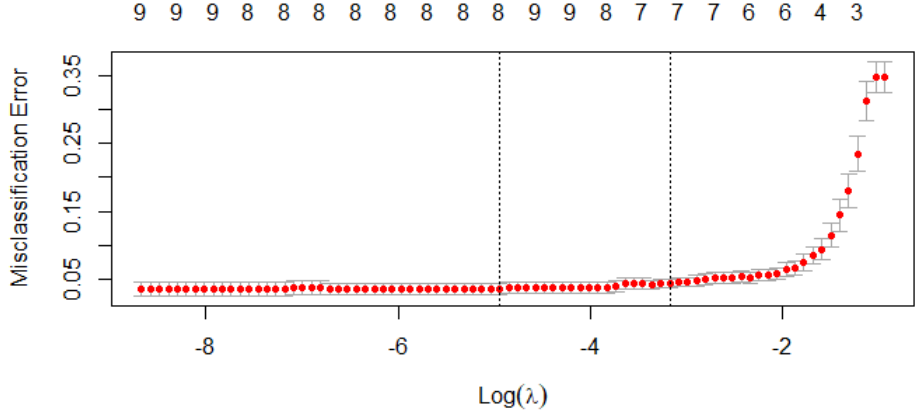
Figure 10. Lasso λ using 10 fold cross validation for the breast cancer data.